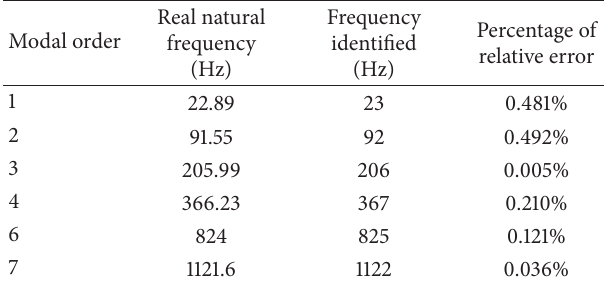
Table 5: Error of natural frequencies identified by maximization negentropy with quasi-Newton method.